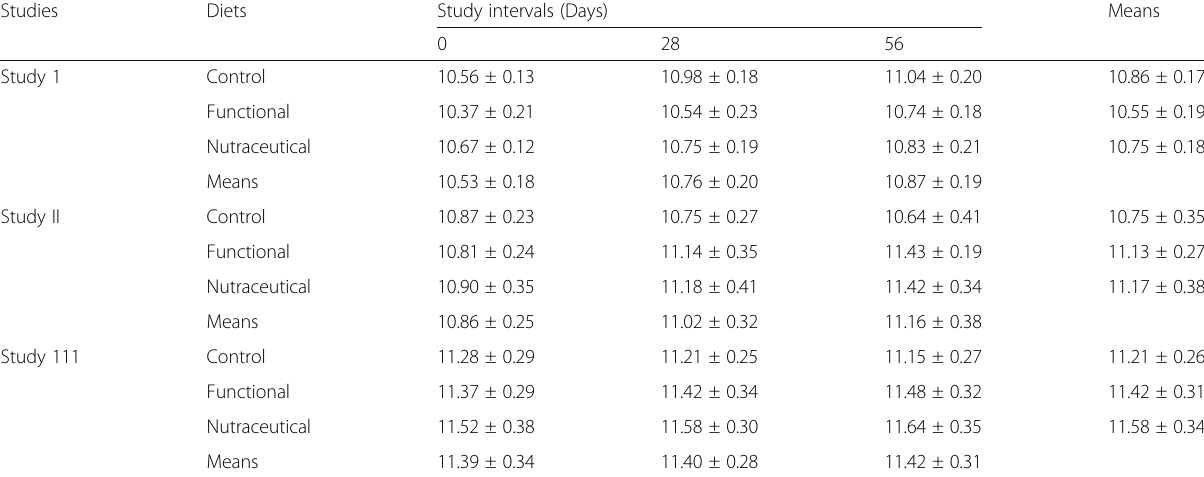
Table 9 Effect of diets and study intervals on WBC (10 3 / μ L) of rats in different studies